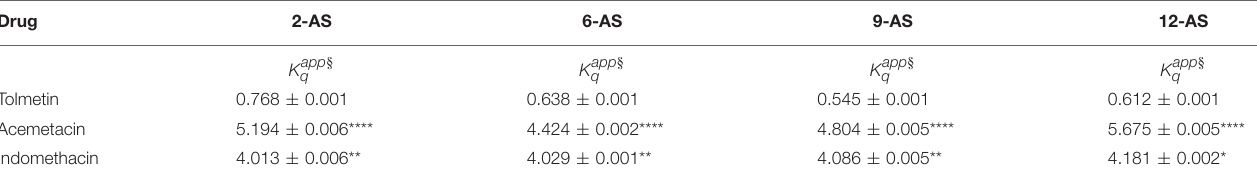
TABLE 2 | Fluorescence apparent bimolecular constants, K app q determined by fluorescence quenching of n -AS probes (incorporated in MLVs at 25.0 ◦ C) by each NSAID studied. Drug 2-AS 6-AS 9-AS 12-AS K app § q K app § q K app § q K app § q Tolmetin 0.768 ± 0.001 0.638 ± 0.001 0.545 ± 0.001 0.612 ± 0.001 Acemetacin 5.194 ± 0.006**** 4.424 ± 0.002**** 4.804 ± 0.005**** 5.675 ± 0.005**** Indomethacin 4.013 ± 0.006** 4.029 ± 0.001** 4.086 ± 0.005** 4.181 ±